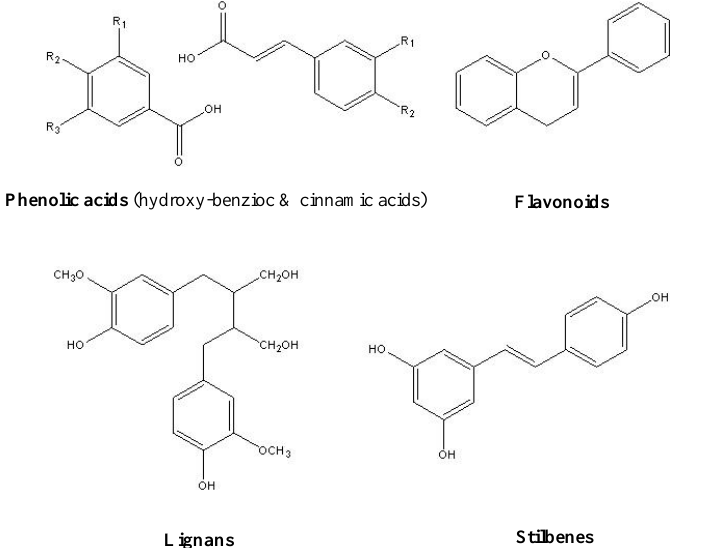
Figure 1. Different groups of polyphenols and their chemical